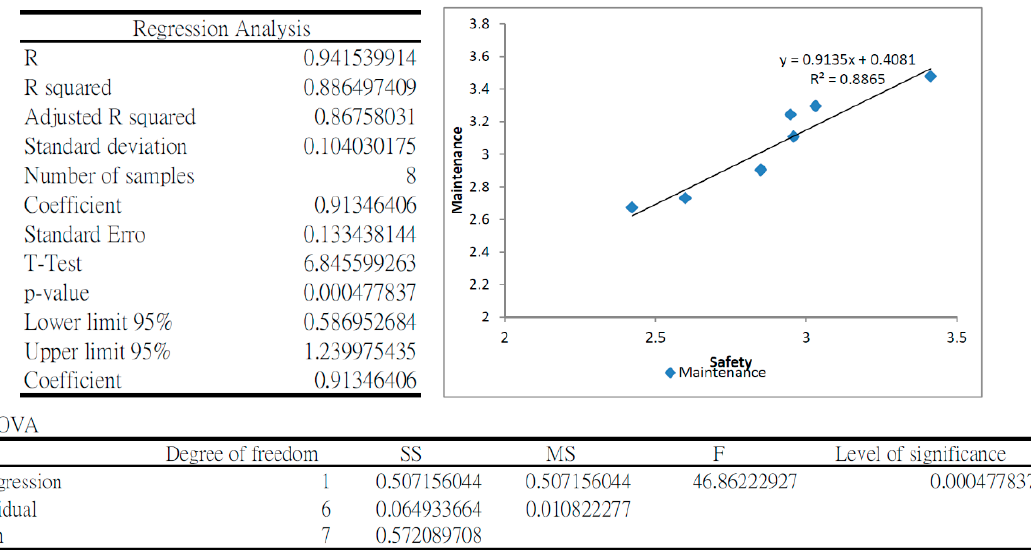
Figure 14. Regression model and analysis.